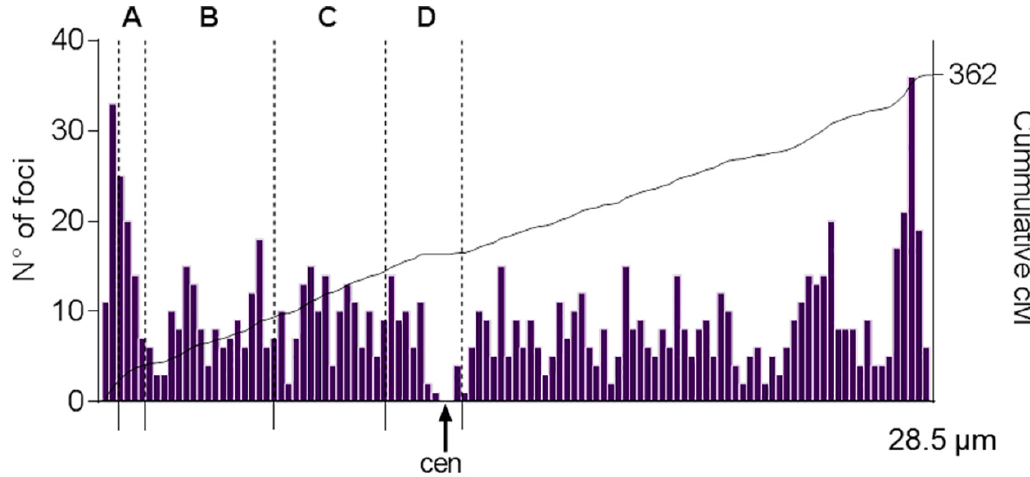
Figure 5. Crossover distribution along SC1. The histogram represents the distribution of MLH1 foci along the largest synaptonemal complex in chicken oocytes. The x -axis indicates the positions of the MLH1 foci on the SC. The end of the short arm is at 0 and the end of the long arm at 28.5 which is the average length of the SC1. The bin width is equivalent to 0.25 µ m. The height of each bar indicates the number of foci observed at a given interval. The continuous line is the cumulative cM along the SC1 calculated from the number of MLH1 foci in 138 pachytene nuclei. SC1 has on average 7.2 MLH1 foci, so the total genetic length of this bivalent is 362 cM (number of crossovers multiplied by 50). The dashed lines mark the average positions of the five BAC-FISH signals. The four intervals delimited by the BAC clones are labeled A to D. cen: centromere position. Table 3. Relationship between SC/DNA ratio and crossover rates at specific intervals on